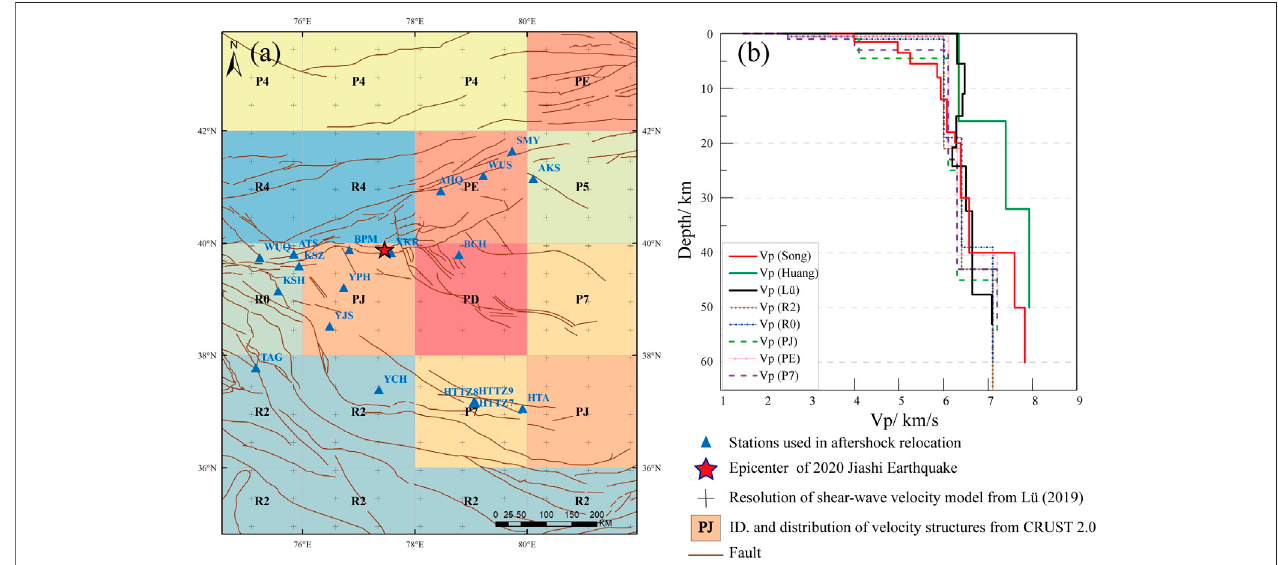
FIGURE3|(A) Thebluetrianglesshowthedistribution oftheseismicstationswhosedatawereusedfortherelocations.Thelargesquaresofdifferentcolorsshow the numbers and spatial locations of the different velocity models extracted from the CRUST2.0 model. The cross signs represent the datapoints for the tomographic velocitymodels. (B) Comparison oftheP-wavevelocity models used forrelocations. Vp (Song), Vp(Huang),Vp(Lü), and Vp(R2)-Vp (P7)wereobtained fromSonget al. (2019), Huang et al. (2006), Lü et al. (2019), and the CRUST2.0 model (http://igppweb.ucsd.edu/ ∼ gabi/rem.html), respectively.